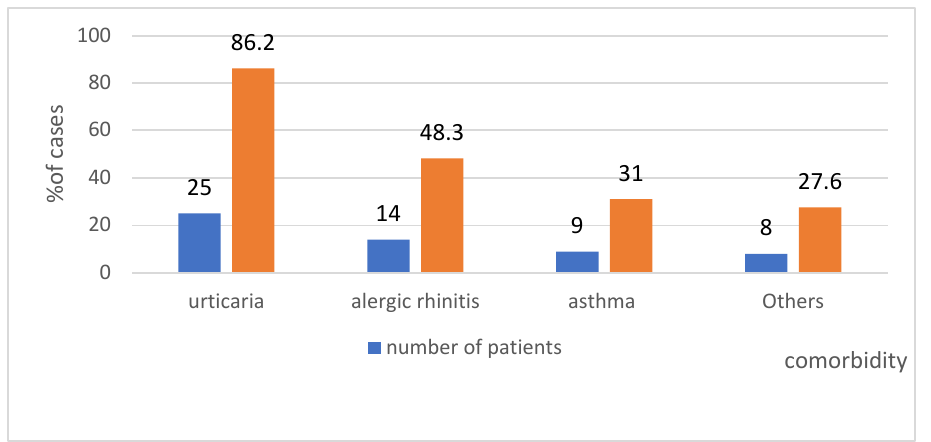
Figure 11. The comorbidity in the study group by % and numbers of patients.